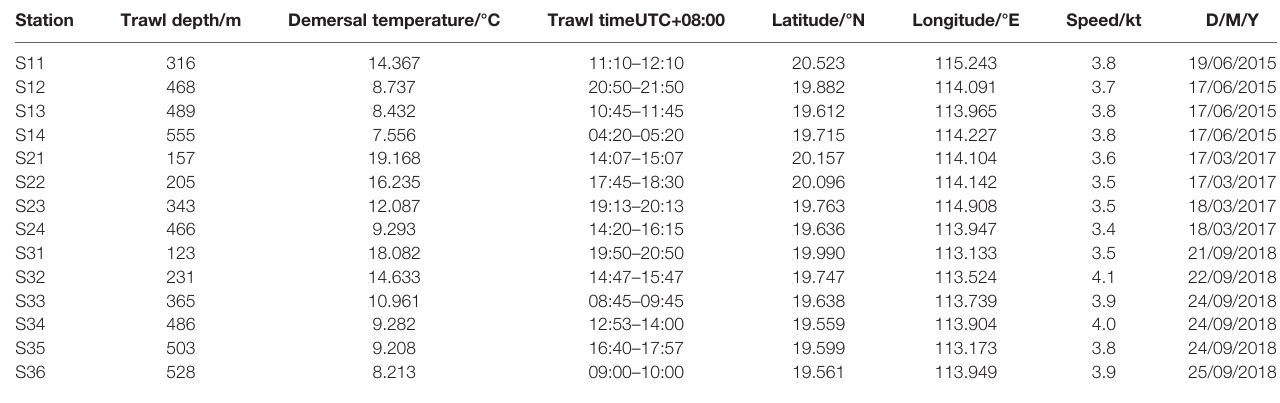
TABLE 1 | Information on sampling station over the